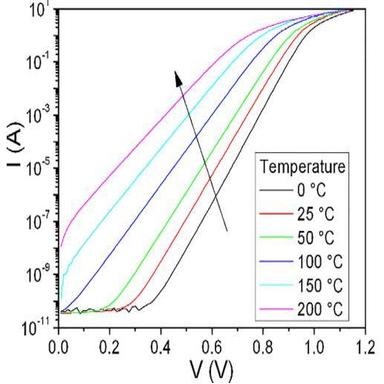
I-V characteristics of power SiC Schottky diode at different temperatures used to evaluate device selected parameters.